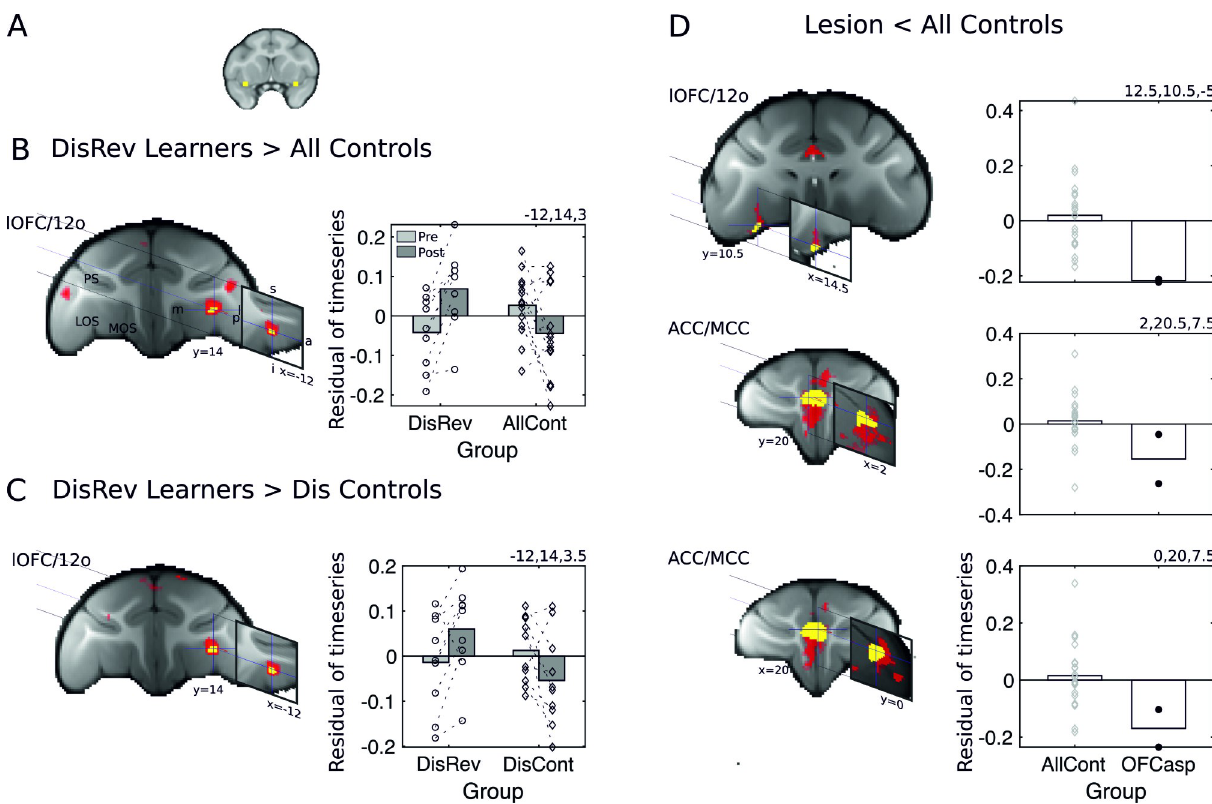
Fig 5. fMRI-measured activity coupling, at rest, between the brain regions identified in Figs 2 and 3. Learning DisRev, relative to all control animals, was associated with changes in functional coupling seeded bilaterally within the plOFC/AI (A) within some of the same set of brain regions as experiment 1: (B) plOFC/AI increased in functional coupling with the lOFC/12o. Results of tfce correction ( p < 0.05) are shown in yellow and red ( p < 0.01). (C) Similar results were found when comparing DisRev learners and the Dis Control group that had learned a discrimination learning task lacking a reversal component. (D) fMRI functional coupling of the plOFC/AI in the OFC aspiration lesion animals versus controls. Functional coupling between the plOFC/AI and lOFC/12o (top) and clusters in the left and right ACC/MCC identified in the ROI analysis (second and third rows). Across analyses, resting-state coupling shows relative increases after learning in the DisRev animals and relative decreases in the NoDis Controls or Dis Controls. 12o, orbital part of area 12; a, anterior; ACC/MCC, anterior cingulate cortex/midcingulate cortex; AI, anterior insula; AllCont, all control; Dis Control, discrimination control; DisRev, discrimination reversal; fMRI, functional magnetic resonance imaging; I, inferior; l, lateral; lOFC, lateral OFC; LOS, lateral orbital sulcus; m, medial; MOS, medial orbital sulcus; NoDis Control, no-discrimination control; OFC, orbitofrontal cortex; OFCasp, OFC aspiration lesion; p, posterior; plOFC, posterior lOFC; plOFC/AI, plOFC extending into AI; PS, principal sulcus; ROI, region of interest; s, superior; tfce, threshold-free cluster enhancement. Data are available on https://www.jeromesallet.org/data-ofc-reversal-learning and https://doi.org/10.5281/zenodo.